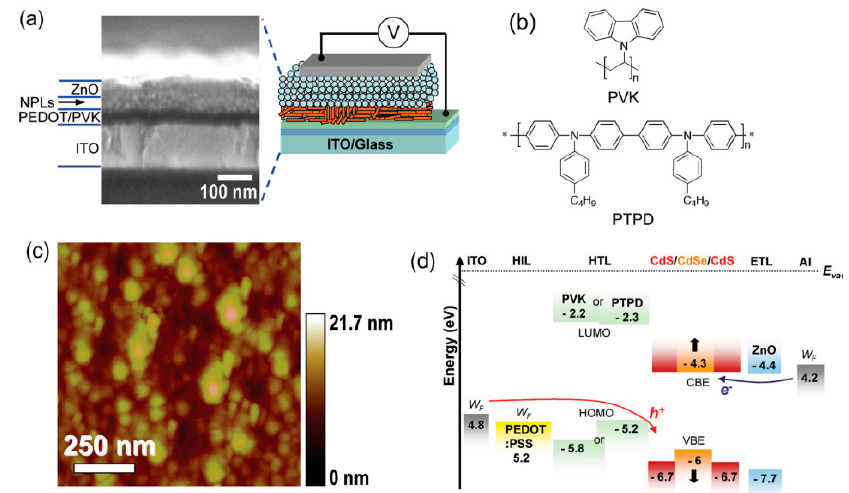
Figure 2. ( a ) Right: the NPL-LED device architecture. Left: cross-sectional scanning electron microscopy (SEM) for device architecture; ( b ) The chemical structure for hole transport materials; ( c ) Atomic force microscopy (AFM) for the thin film of NPLs; ( d ) The energy levels, VBE represents valence band edge and CBE represents conduction band edge. The black arrow indicates a shift of the band edge because of the quantum confinement. Adapted from [35], with permission from © 2013 John Wiley and Sons.